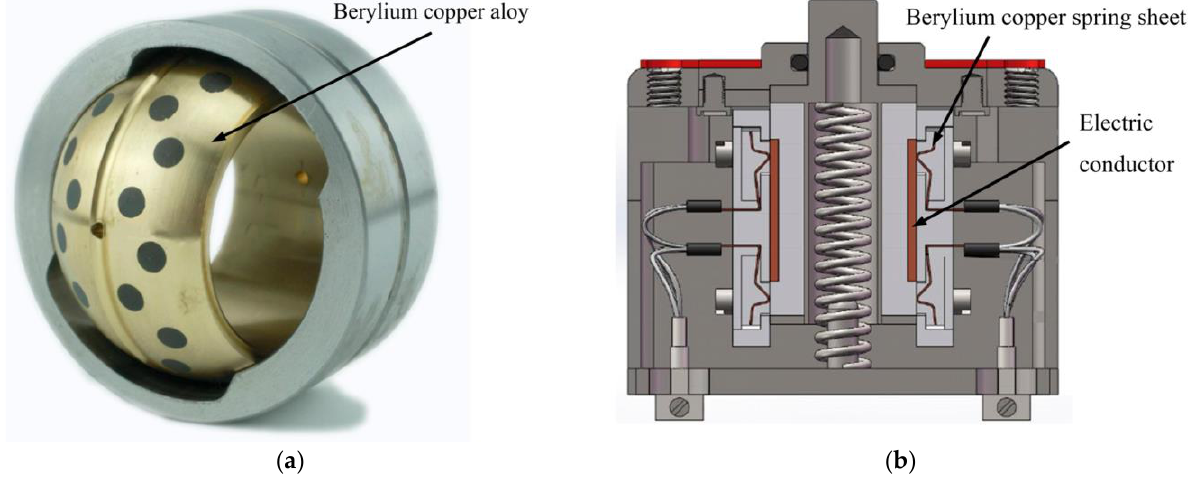
Figure 1. Typical mechanical components made of beryllium copper alloy. ( a ) Joint ball bearing; ( b ) high temperature slide switch.